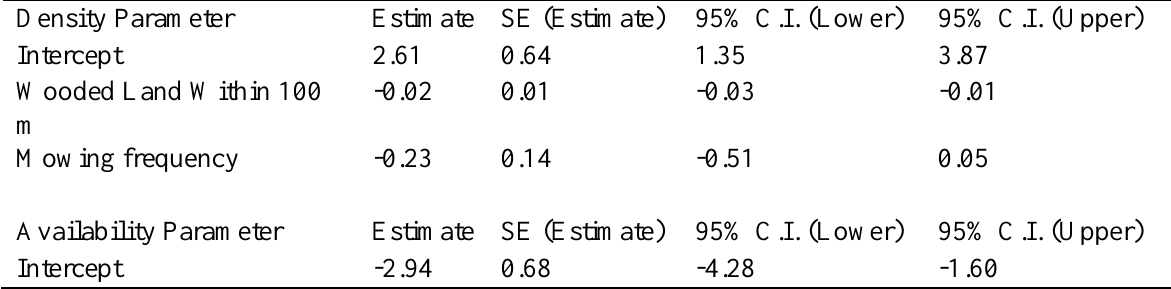
Table A2.B . Second-highest-ranking hierarchical distance-sampling model (AIC ∆ AIC =2.15, AIC weight=0.12) for Clay-coloured Sparrows along 34 transmission line study c sites in Winnipeg, Manitoba, Canada in 2007 (n=102 surveys), assuming a uniform detection probability with increasing distance of birds from the transect line and no effects of Julian date, time of morning, or observer experience on availability for